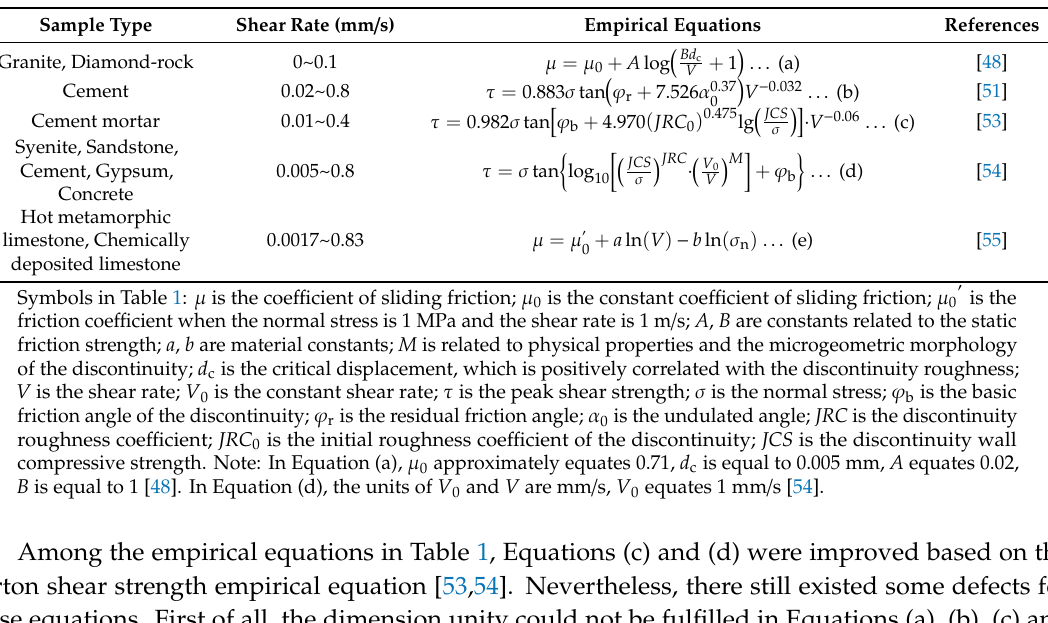
Table 1. Empirical equations of shear strength considering the shear rate.